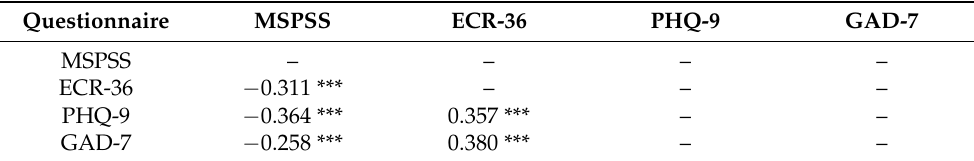
Table 4. Pearson correlations between the variables used in the mediation model.